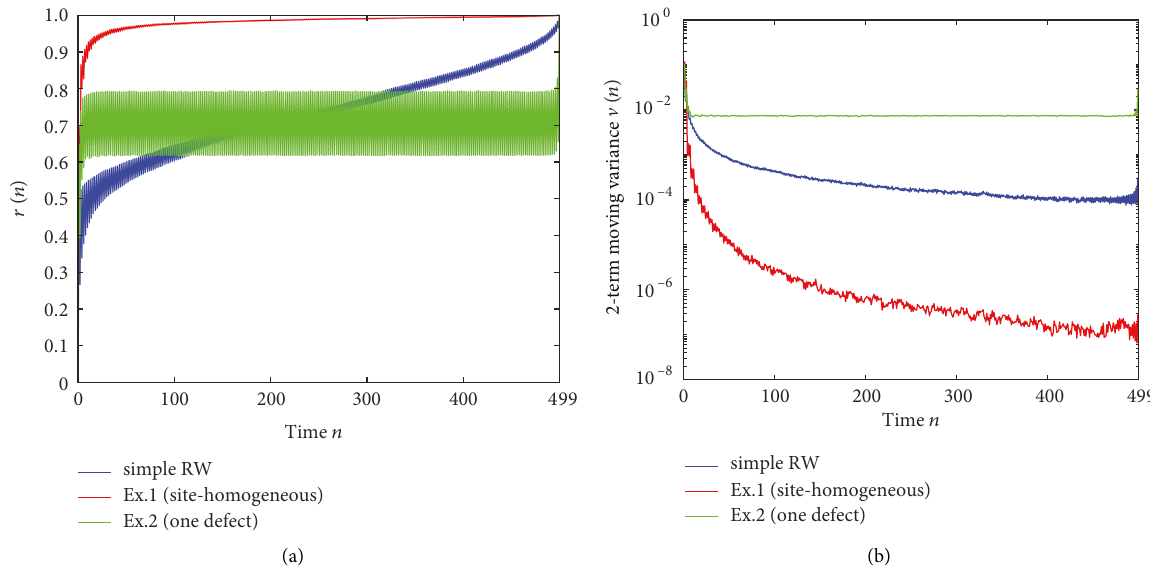
Figure 4: (a) Degree of deciding future direction is characterized through the analysis of paths derived via QWRWs or the simple random walk ( N � 499, K � 100000). According to Eq. (26), walkers are counted to the numerator of r ( n ) in the only case that the sign at time n matches the final one. Note that it is not counted in case of S n � 0. QWRWs of Exs. 1 and 2 exhibit a dramatic increase right after the initial time, which is another manifestation of linear spreading. (b) The 2-term moving variance (MV) v ( n ) of r ( n ) . QWRW of Ex. 2 exhibits a larger variance, which clearly indicates localization.